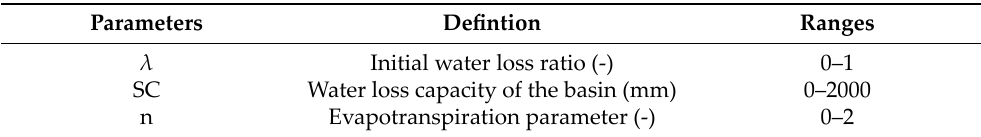
Table 1. The parameters of TMPH.